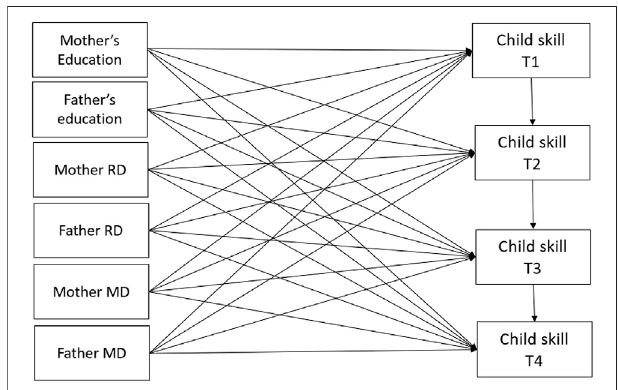
FIGURE1| Thebase-modelfor parental measures predicting children ’ s skills.